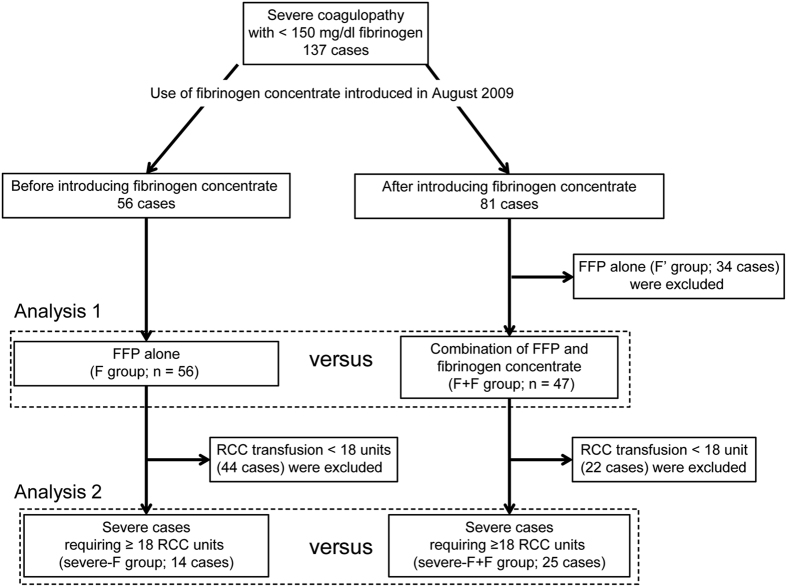
Flow chart showing the enrolled patients for this study.